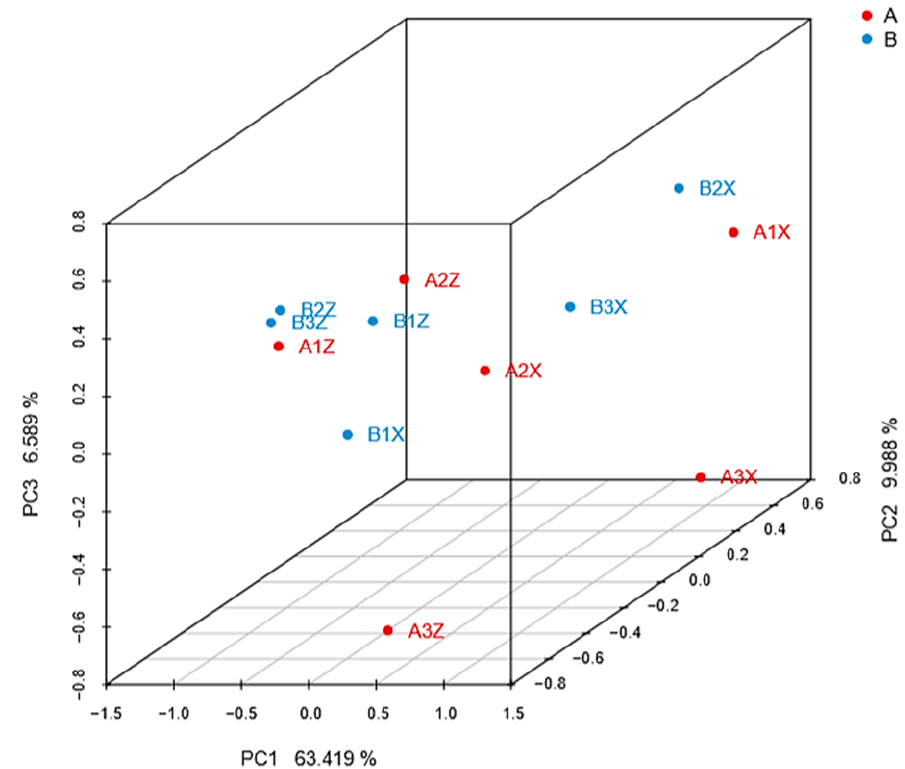
Figure A1. Principal component analysis of bacterial communities in two types of litter from plantation forest (A) and original forest (B).